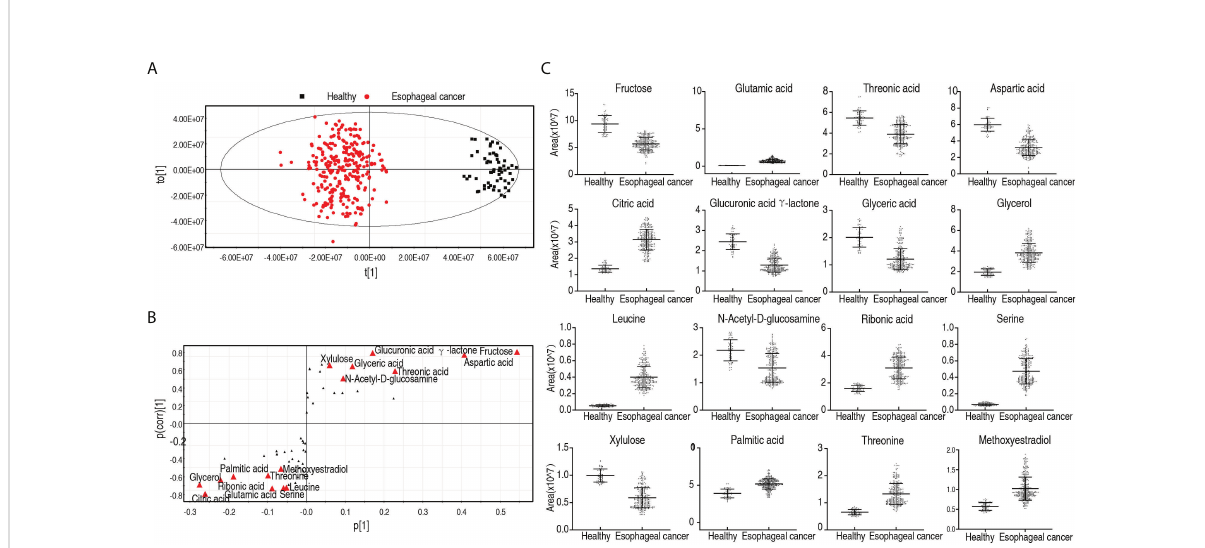
FIGURE 4 Identi fi cation for biomarkers in patients with esophageal cancer. (A) OPLS-DA analysis of healthy group and esophageal cancer group. Each dot represents one technical repeat in the plot. (B) S-plot is generated from OPLS-DA. The triangle represents metabolites and candidate biomarkers are highlighted in red. (C) Abundance of biomarkers. Results (C) are displayed as mean ±